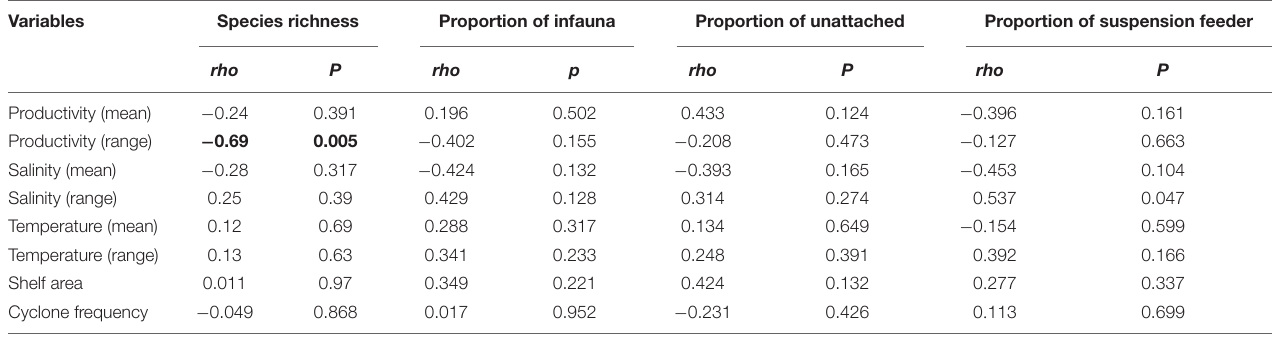
TABLE 4 | Highest ranked logistic models ( (cid:49) AICc ≤ 2) investigating environmental correlates of the species richness and ecological categories of the marine bivalves. Variable to be explained